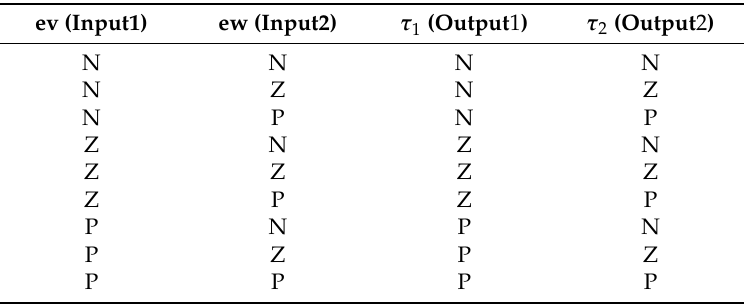
Table 7. Rules for the fuzzy logic